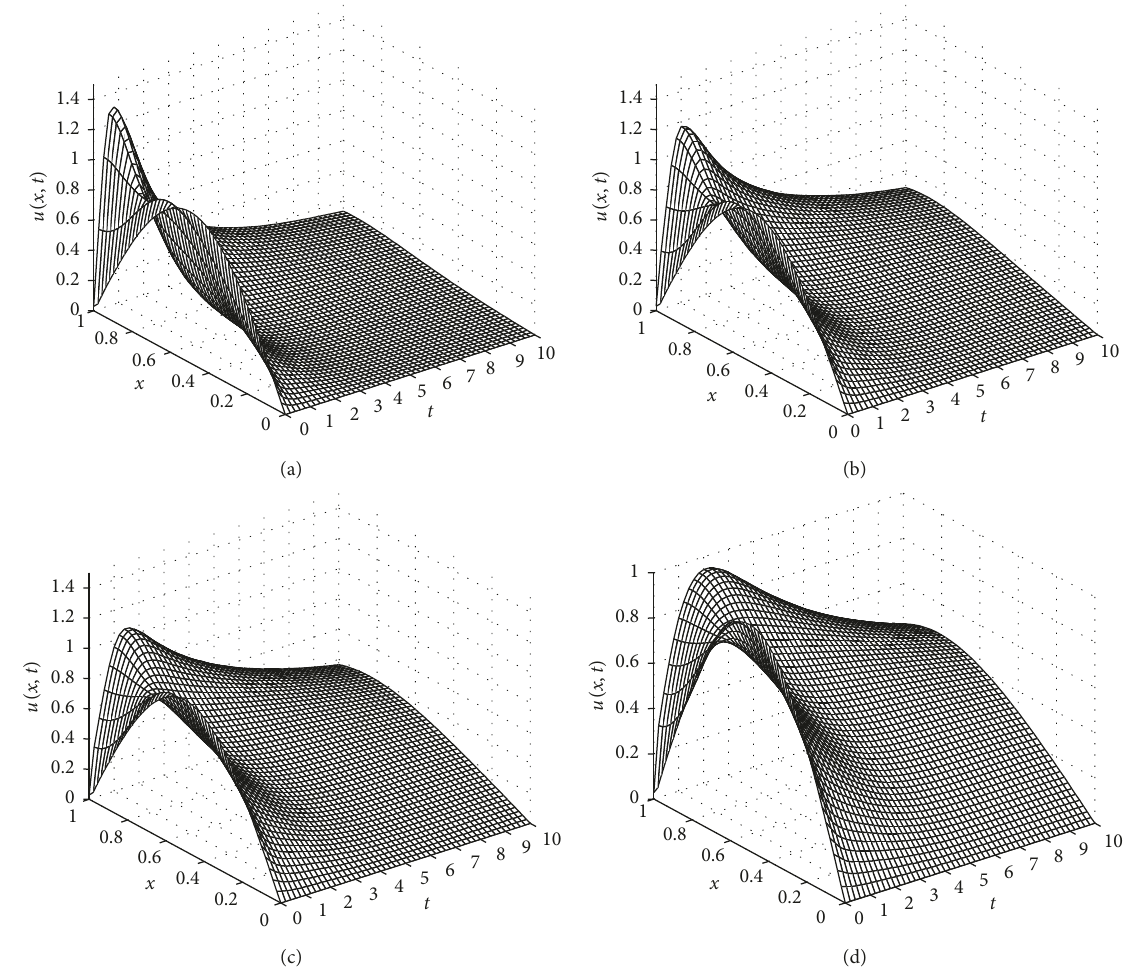
Figure 1: A 3D view of the dynamics of the MGKdVB equation utilizing the first nonlinear adaptive controller μ � 0 . 001, c � 0 . 0005, r � 0 . 2, r � 0 . 2, and u ( x ) � sin ( π x ) . (a) α � 1; (b) α � 2; (c) α � 3; (d) α � 4. c 2 1 2 0